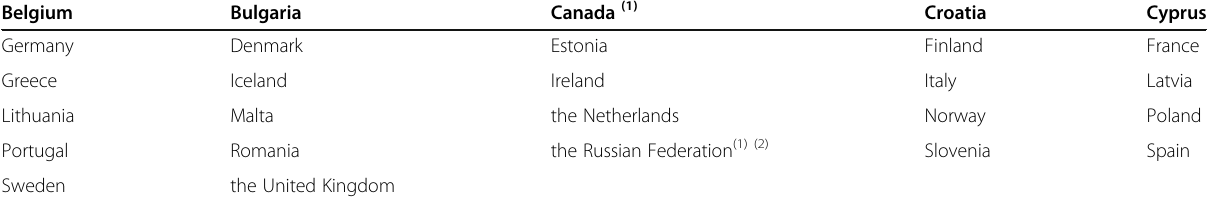
Table 1 Country List of the Member Maritime Authorities of Paris MOU Belgium